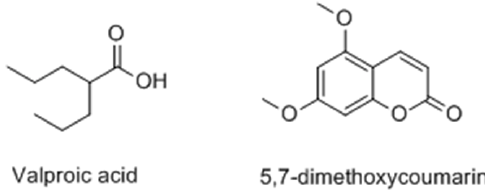
Figure 20. Structures of valproic acid and 5,7-dimethoxycoumarin.